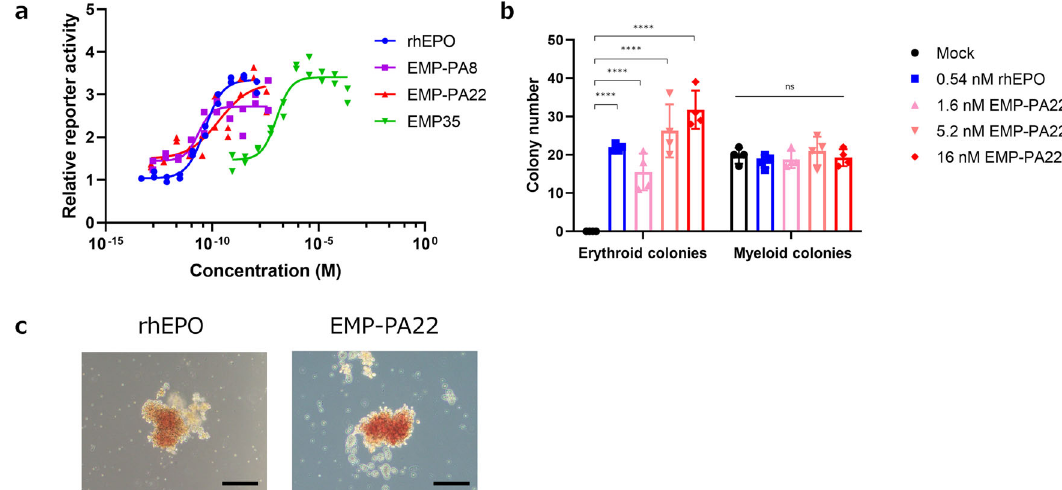
Fig. 4 Bioactivity evaluation of EPO mimetic STaMPtides. a Signaling potencies induced by EMP-PA8 and EMP-PA22. EPOR-JAK2 signaling activation by EMP-PA8 (purple squares), EMP-PA22 (red triangles), rhEPO (blue circles), and monomeric EMP35 (green inverted triangles) was evaluated by EPOR- JAK2 functional reporter assay. The mean and individual values are shown. b Colony-forming cell assay. hPBMCs were cultured in methylcellulose culture medium in the absence (black bar) or presence (blue bar) of 0.54 nM rhEPO or 1.6 – 16 nM EMP-PA22 (red bars). Number of erythroid and myeloid colonies formed from 2 × 10 5 hPBMCs were counted. The mean ± SD with individual values are shown from the results of quadruplicate experiments. **** p < 0.0001. c Morphology of erythroid colonies formed in methylcellulose medium in the presence of 0.54 nM rhEPO or 16 nM EMP-PA22 after 13 days of culture. Scale bars = 200 μ